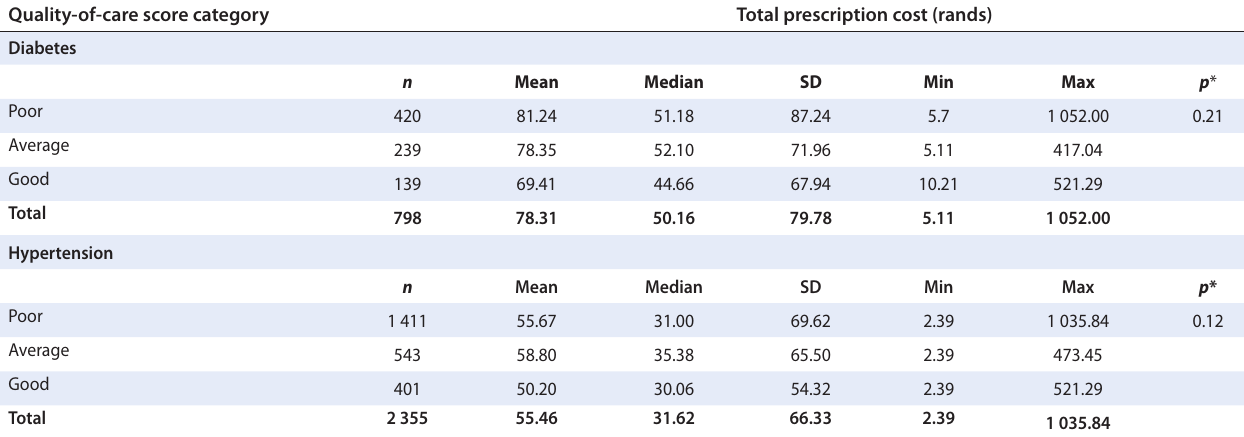
Table 4: Quality-of-care scores for diabetes and hypertension and the cost of prescriptions Quality-of-care score